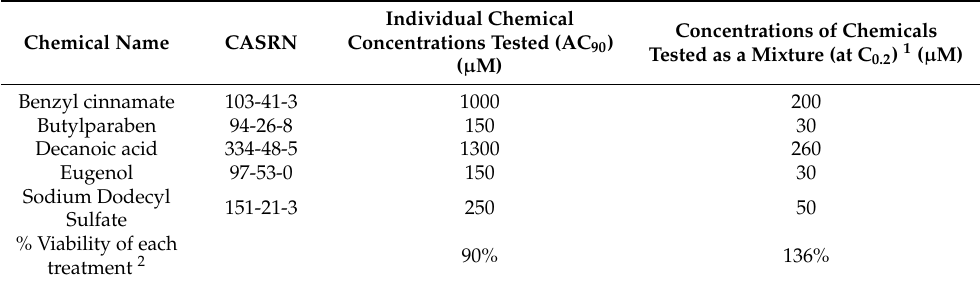
Table 1. The AC 90 concentrations of individual household chemicals and a household chemical mixture used to evaluate exposure-induced changes in PPAR γ expression and INSR expression in HepG2 cells. The resulting viabilities of each evaluated condition are also provided. Note that higher concentrations of chemicals were tested as a combined mixture, but caused a sudden, significant drop in viability at doses higher than C 0.2